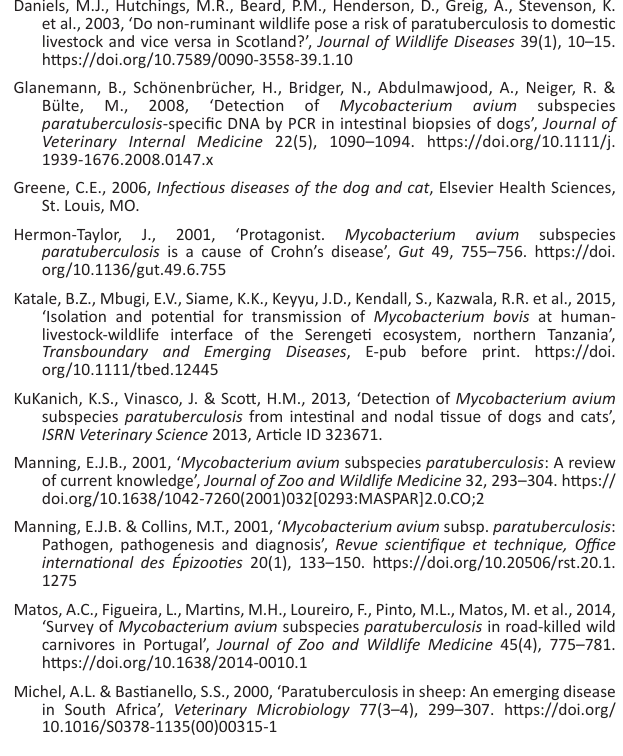
FIGURE 5: Map of Johne’s positive sheep farms in the Western Cape